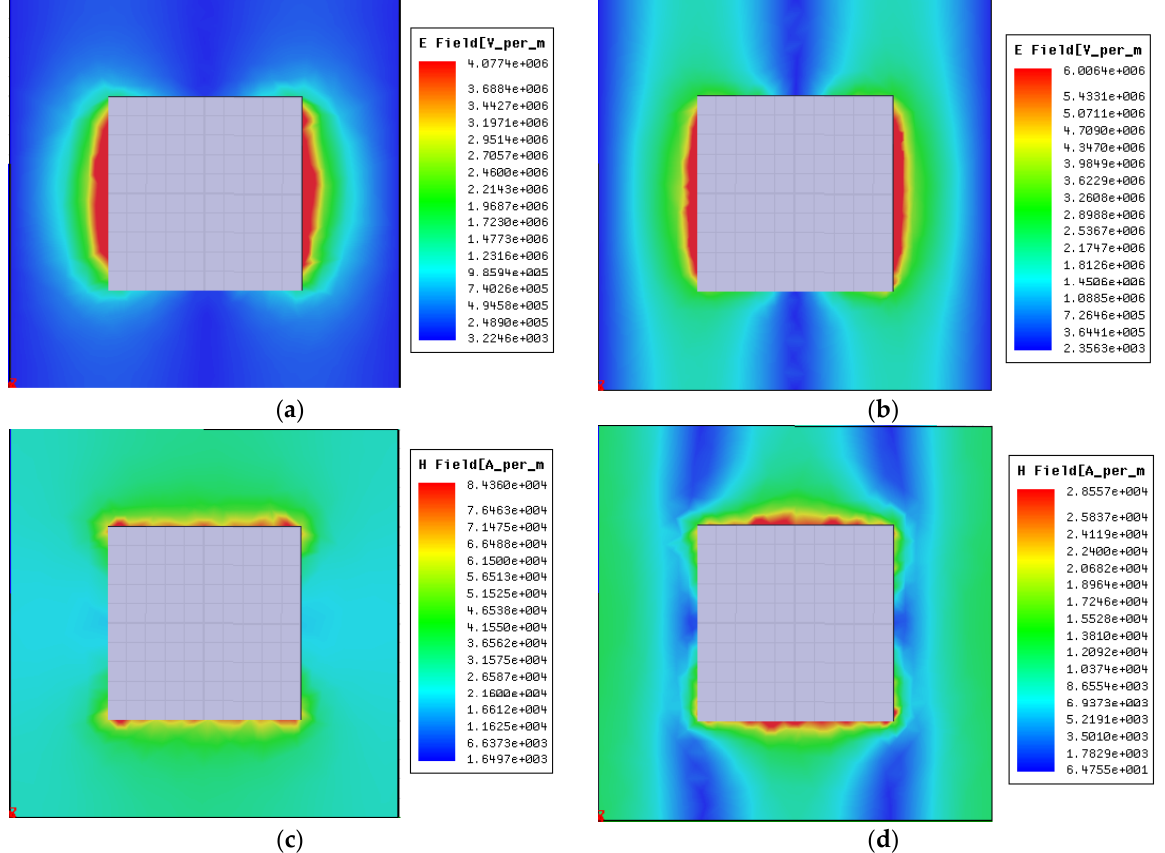
Figure 6. Distribution of the electric field simulated by HFSS for ( a ) first mode ( b ) second mode and the magnetic field for ( c ) first mode ( d ) second mode.